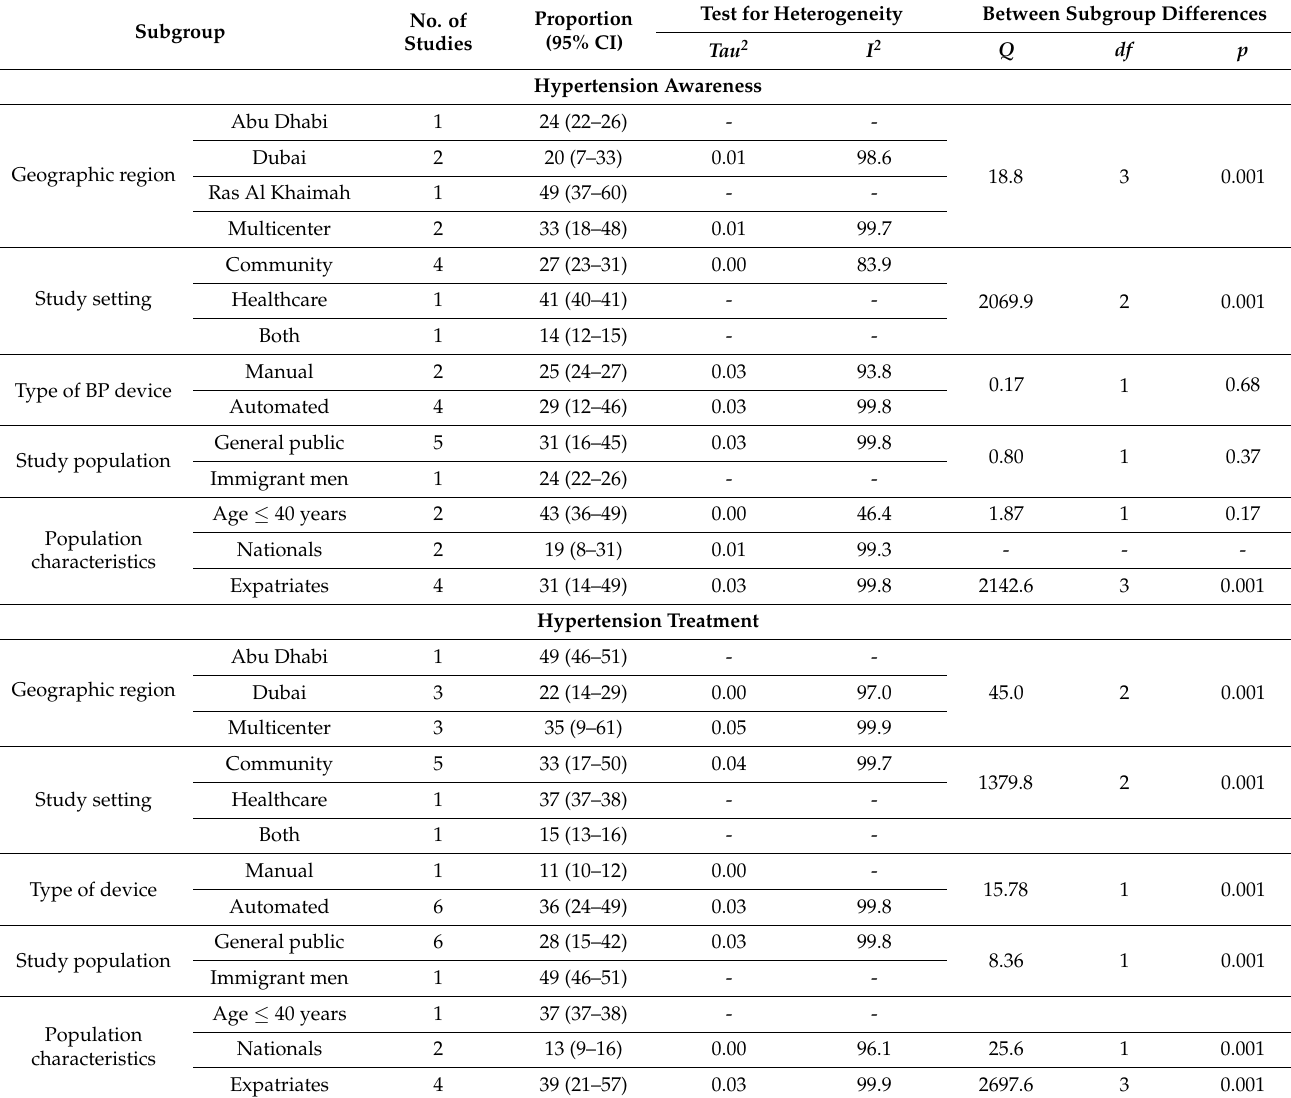
Table 3. Subgroup analysis for the potential variables between the studies of Hypertension awareness, treatment, and control in the United Arab